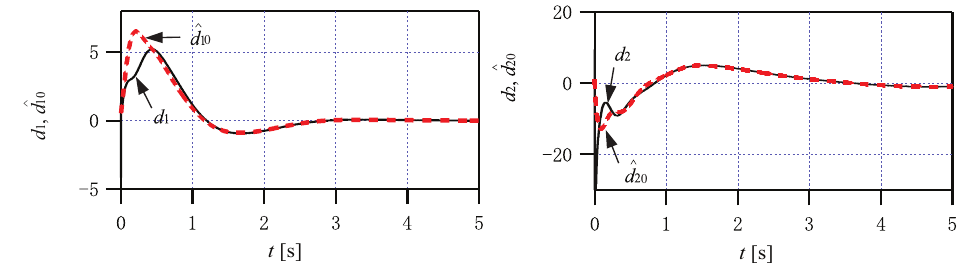
Figure 2. Actual value and observed values of the disturbances d 1 and d 2 in